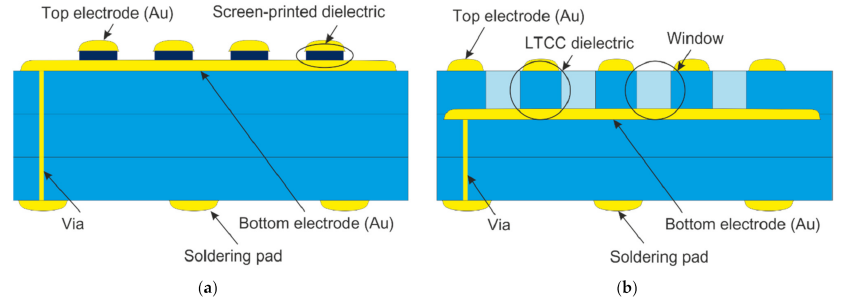
Figure 3. The cross-section schematic for two structural variants of the sensor: ( a ) with screen-printed dielectric layer separating electrodes (Single Substrate, SS); ( b ) with electrodes printed on separate LTCC substrates and stacked together (Multi Substrate,